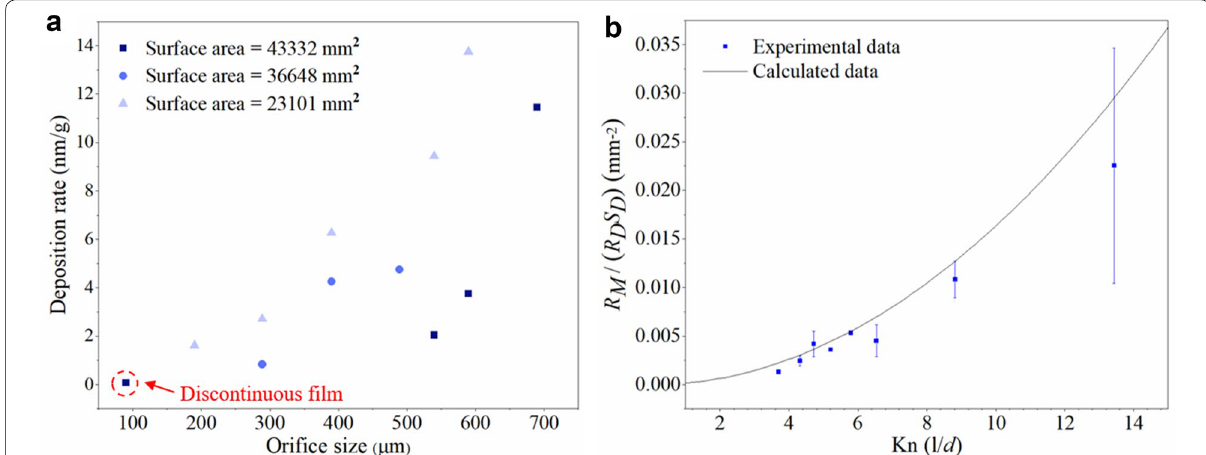
Fig. 3 Deposition outputs. a The deposition rates in different chambers with different orifice sizes, and b comparison of the experimental results and the model, calculated by Eq.